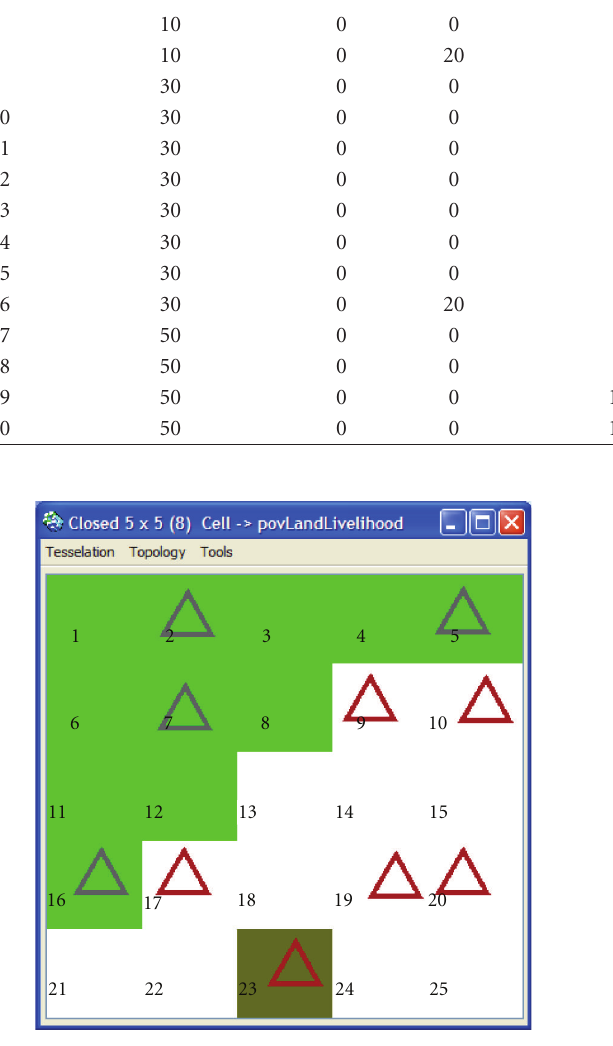
Figure 6: Scenario C: nine players pool their money to invest in oil palm